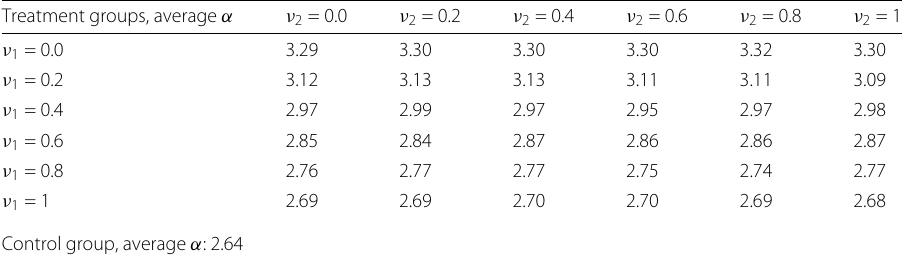
Table 9 Average values of the power-law model’s exponent α in the control group and in the treatment group by values of ν 1 and ν 2 , computed over k ≥ k min Treatment groups, average α ν 2 = 0.0 ν 2 = 0.2 ν 2 = 0.4 ν 2 = 0.6 ν 2 = 0.8 ν 2 = 1 ν 1 = 0.0 ν 1 = 0.2 ν 1 = 0.6 ν 1 =